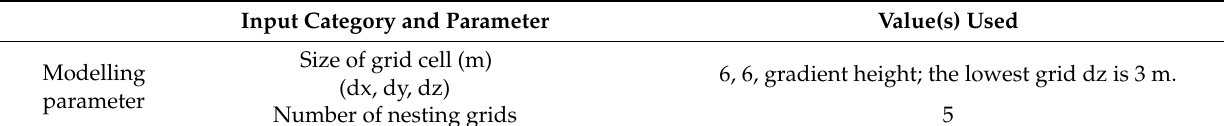
Table 3. Main modelling parameter and configuration file settings used for ENVI-met